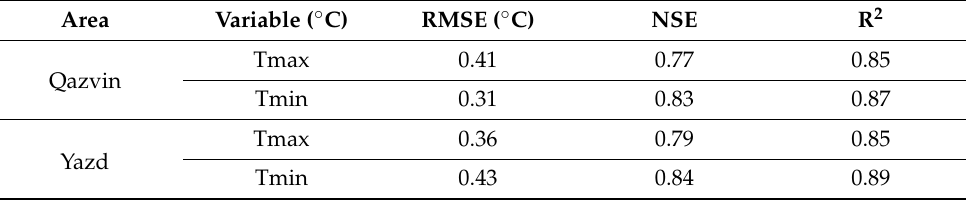
tion period from 2011 to